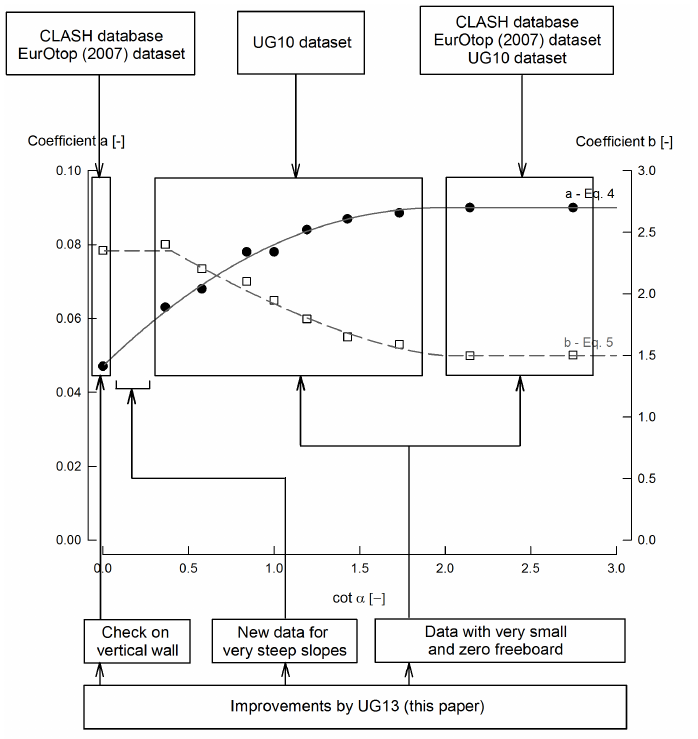
Figure 2. Best fit per slope angle α of the a and b coefficients for the UG10 dataset and selected tests of the CLASH database, with the van der Meer and Bruce [11] formulae expressions for a V & B (Equation (4)) and b V & B (Equation